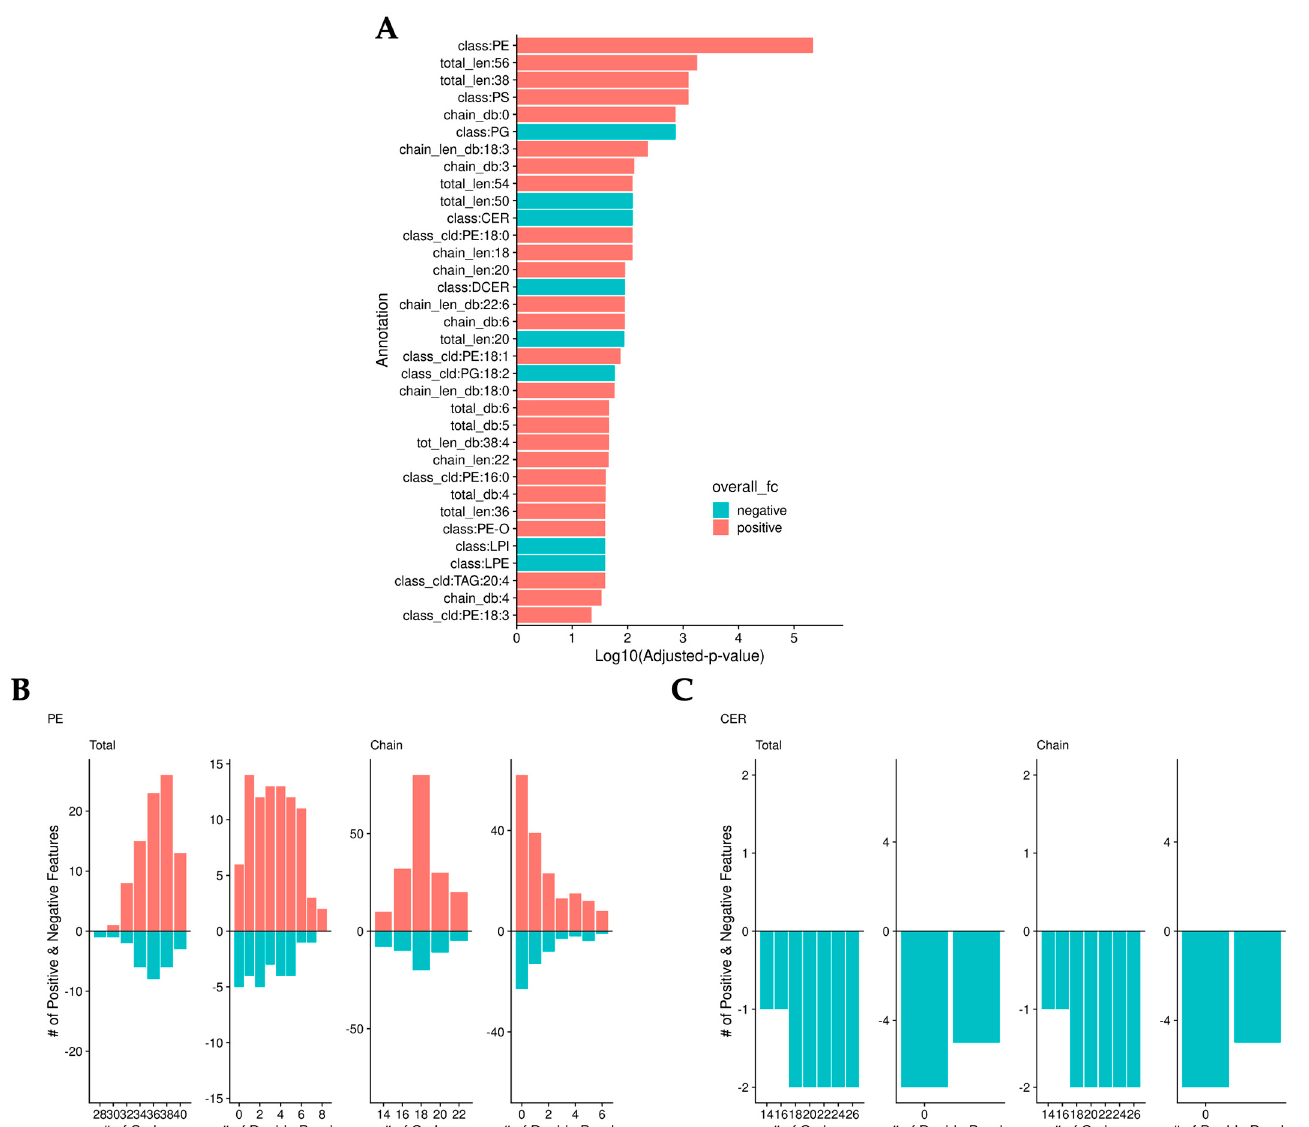
Figure 4. Bilirubin nanoparticles regulate phosphatidylethanolamine (PE) and ceramide (CER) levels within the liver of obese mice. ( A ) Log 10 (adjusted-p-values) from binomial tests of lipid annotations. Color represents whether there are more positive (red) or negative (blue) log-fold-change lipids. The number of positive (red) and negative (blue) LogFC lipids is determined by the total and chain numbers of carbon and double bonds in PE ( B ) and CER ( C ).